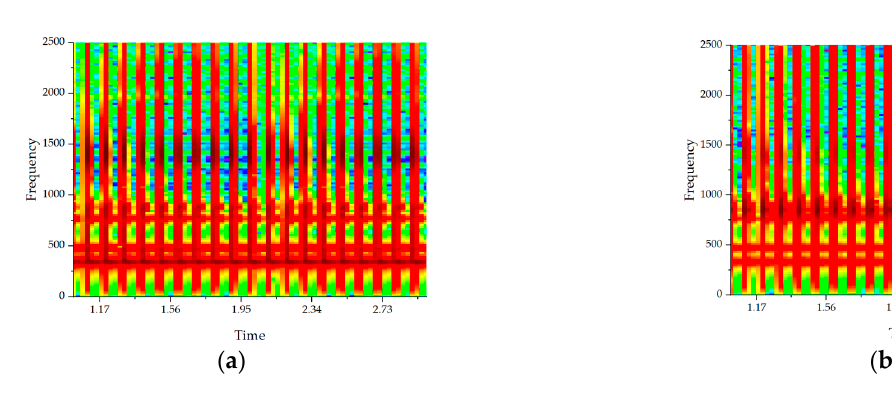
Figure 14. Acceleration response of random variable amplitude continuous impulse excitation.